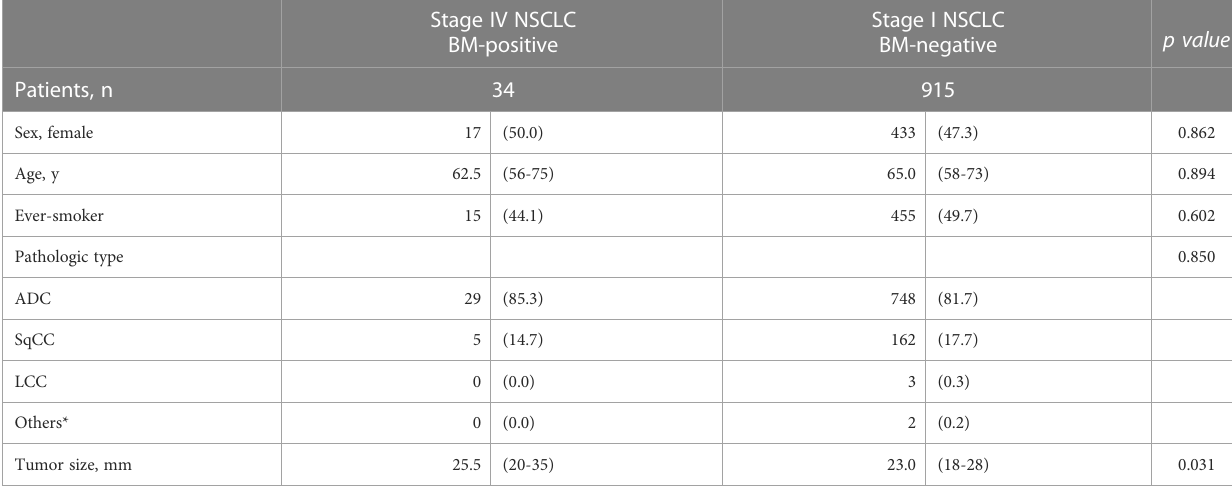
TABLE 2 Group comparison of participants who underwent brain MRI according to the presence of isolated brain metastasis at diagnosis.